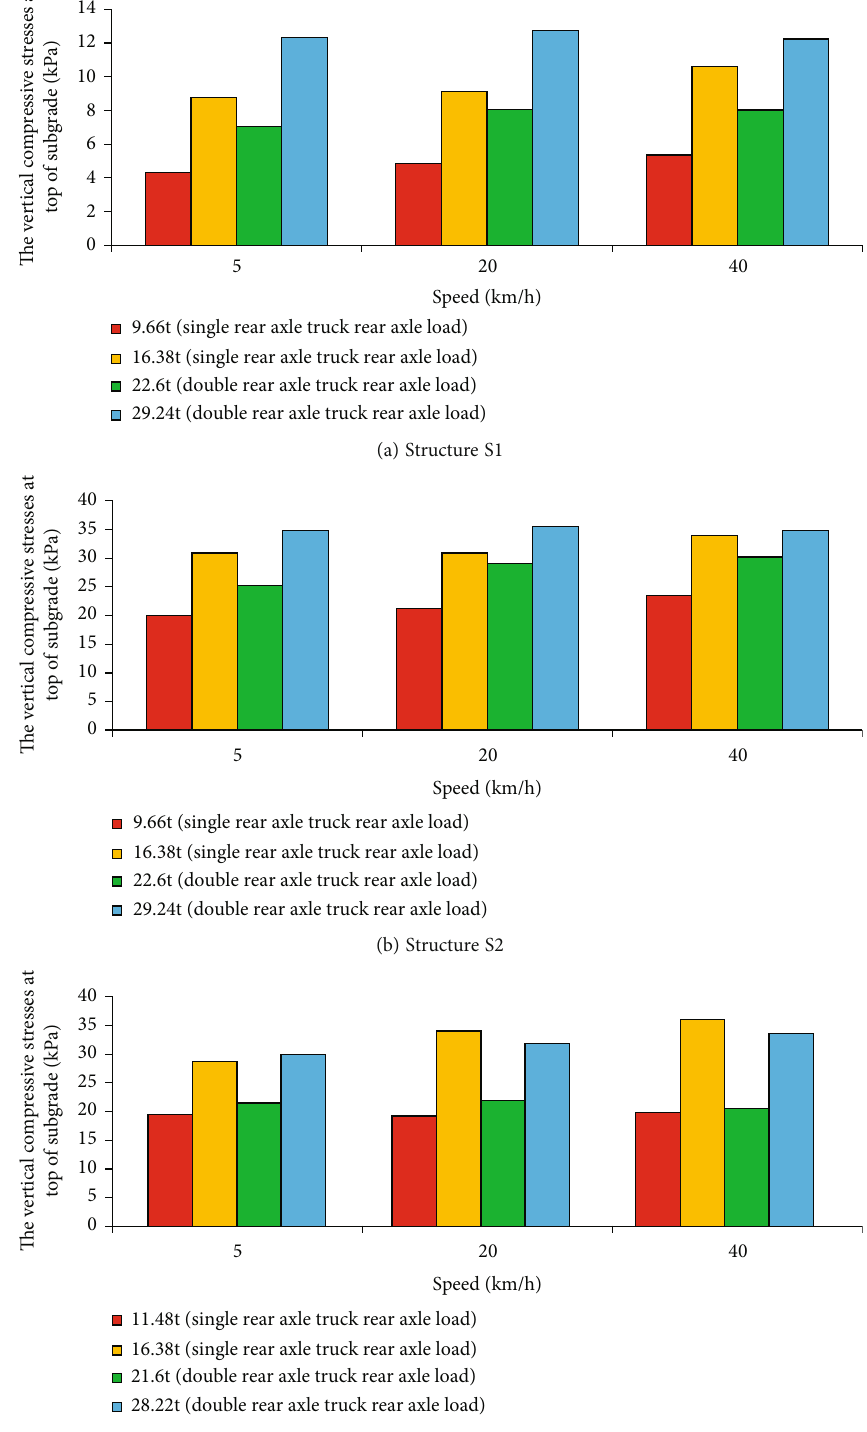
Figure 7: Relation between vertical compressive stresses at top of subgrade and axle